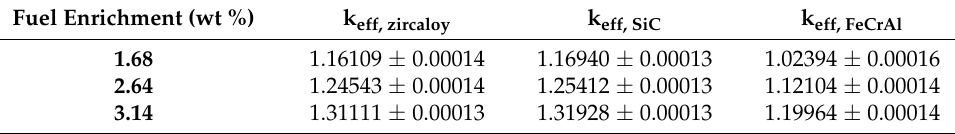
Table 4. k eff values for different pin-cell enrichments for three cladding materials at